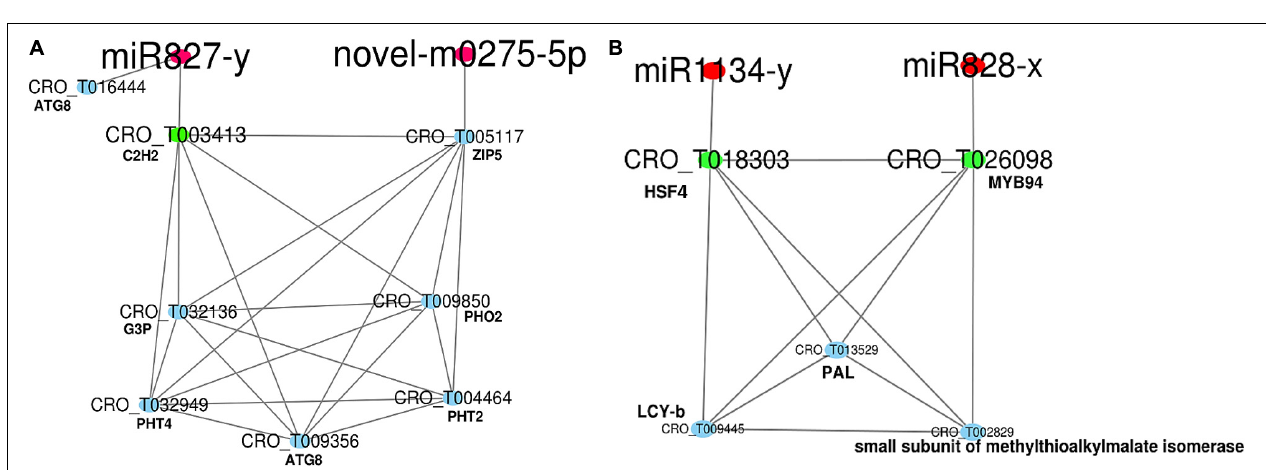
FIGURE 4 | miR164-NAC1 regulatory network highly related to CLas infection. The red nodes are miRNA. The green and yellow nodes are transcription factors (TFs). The blue nodes are genes. Red lines indicate connections to TFs.